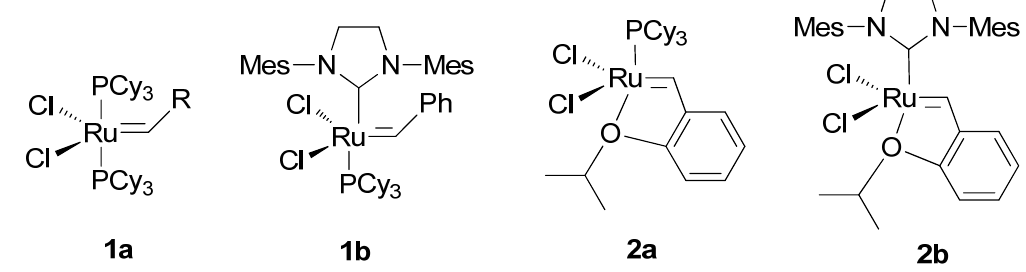
Figure 1. Ruthenium carbene metathesis